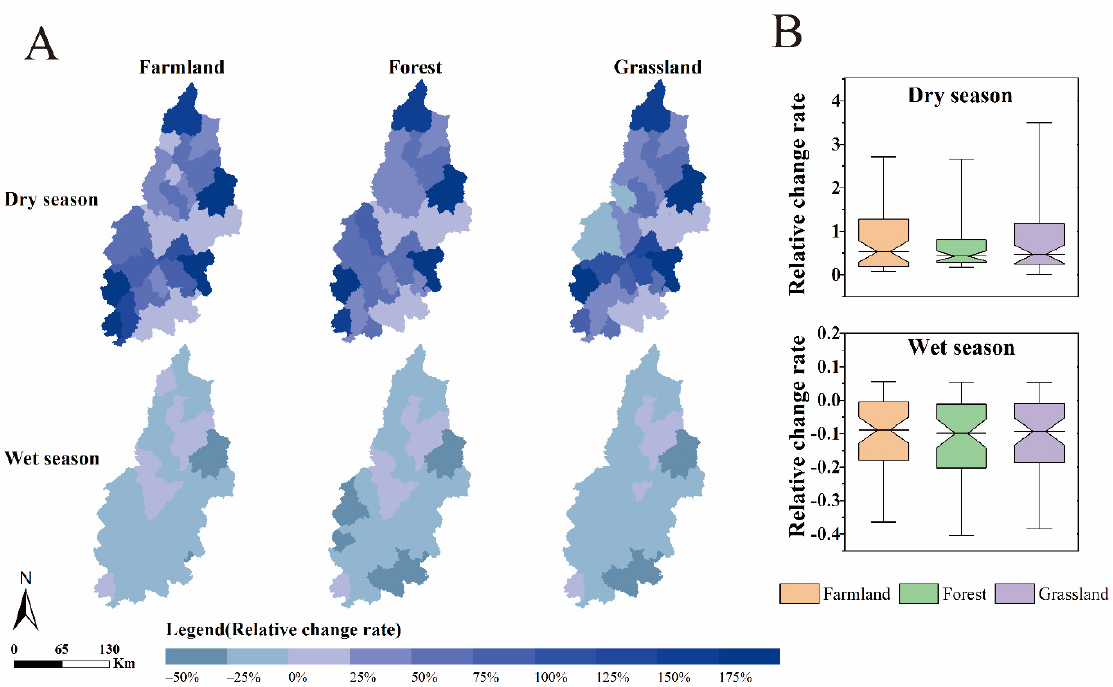
Figure 9. Relative changes in WCA of each ecosystem under climate change scenarios (dry season). ( A ) Spatial distribution of WCA evolution for each ecosystem; ( B ) Relative rate of change in WCA for each ecosystem.